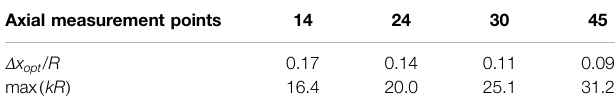
TABLE 1 | Optimal axial spacing and upper limit of solvable